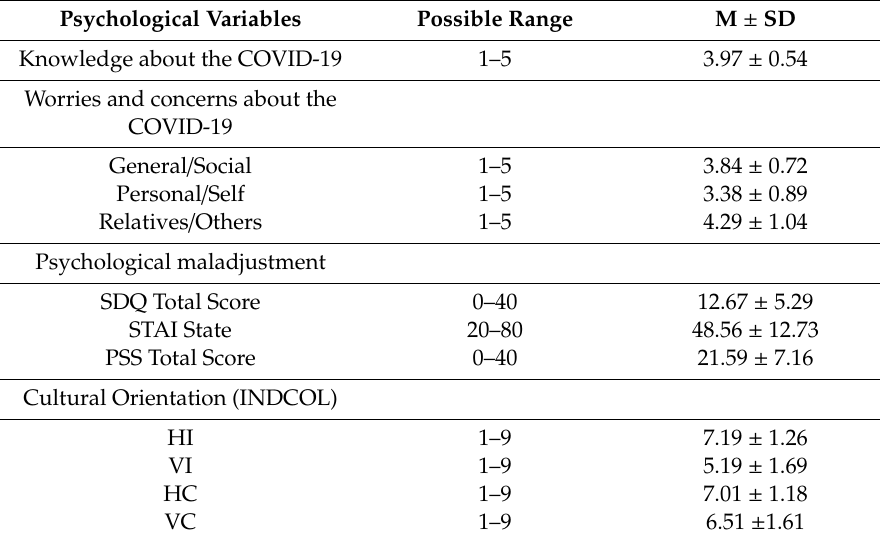
Table 2. Descriptive statistics of knowledge, worries, concerns, and emotional and behavioral reactions about COVID-19 and cultural